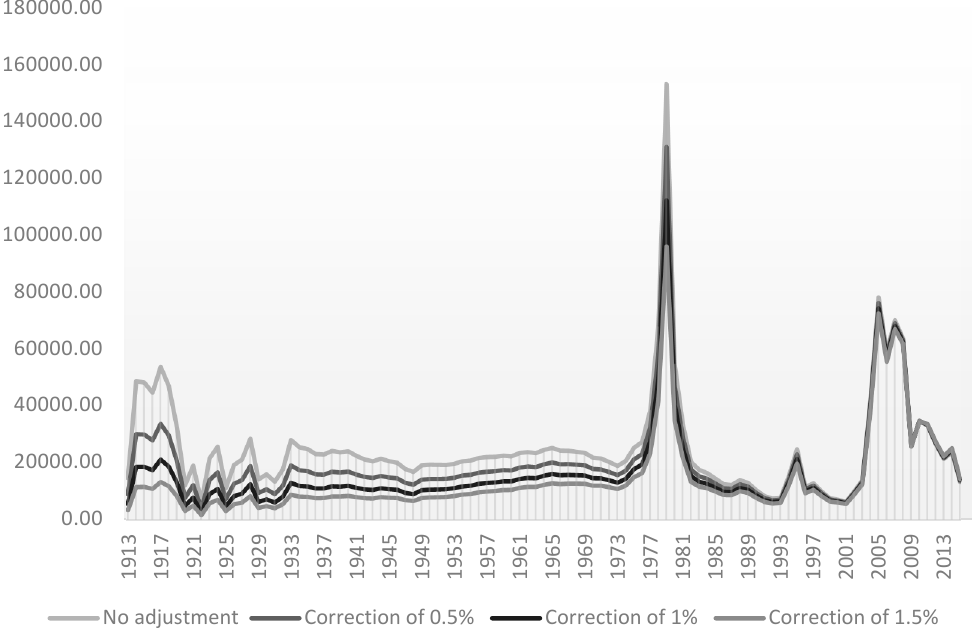
Figure 5. Annual molybdenum real prices in dollars per metric ton ($/ton) from 1913 to 2015 (2010 = 100%). Prices of authors own estimations based on [46]. Resource prices deflated by the CPI and real prices corrected with zero, 0.5%, 1.0% and 1.5% adjustments [50].